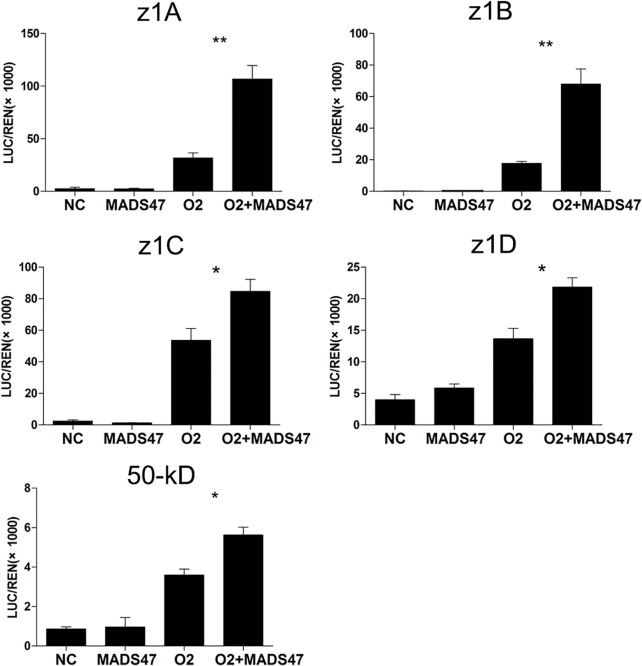
Relative transactivation of ZmMADS47 to different zein genes in onion cells.LUC/REN indicates the ratio of the firefly luciferase activity and the renilla reniformis activity. Error bars represent SD (n = 3) (*P < 0.05, **P < 0.01, ***P < 0.001, Student’s t test). NC respersent to those with the reporter genes (LUC/REN) alone.